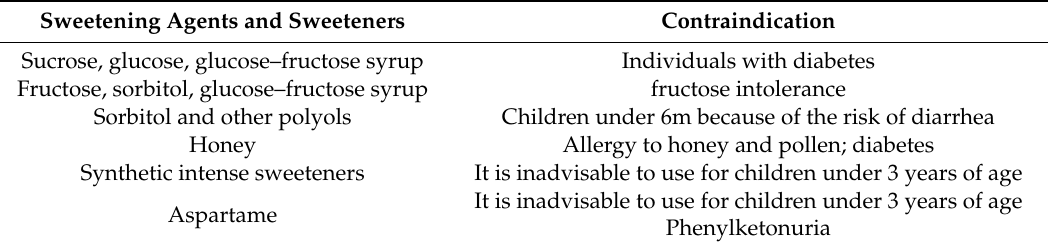
Table 2. Contraindications in the consumption of products with certain sweetening agents and sweeteners present in dietary supplements for children